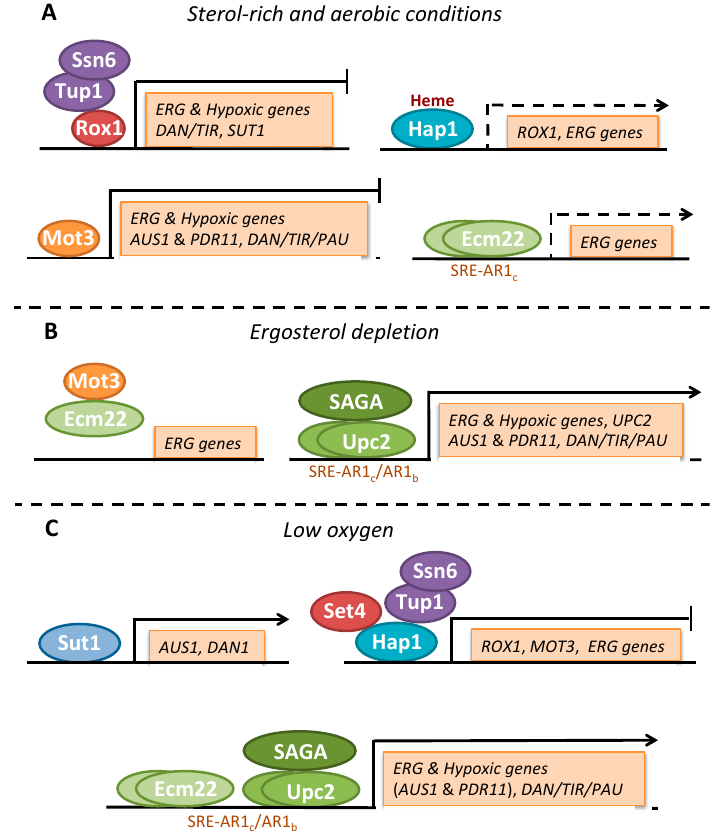
Figure 3. Transcriptional regulation of S. cerevisiae genes involved in ergosterol biosynthesis and uptake in response to low sterols or oxygen. ( A ) Under normal growth conditions, basal ERG gene expression is mostly maintained by Ecm22 and Hap1. Moreover, Mot3 and Rox1 (in a Tup1-Ssn6-dependent manner) inhibit the expression of hypoxic and ergosterol uptake genes. ( B ) Upon sterol depletion, Upc2 activates the transcription of ERG genes probably by recruiting the SAGA complex. ( C ) A drop in oxygen availability decreases heme levels, which lead to the Tup1-Ssn6 and Set4 recruitment by Hap1 to repress the expression of some ERG genes, ROX1 and MOT3 . The decrease in Rox1 and Mot3 levels increases the expression of ERG , hypoxic and sterol uptake genes in a Upc2-Ecm22-dependent manner. Finally, Sut1 activates the transcription of AUS1 and DAN1 , but not PDR11